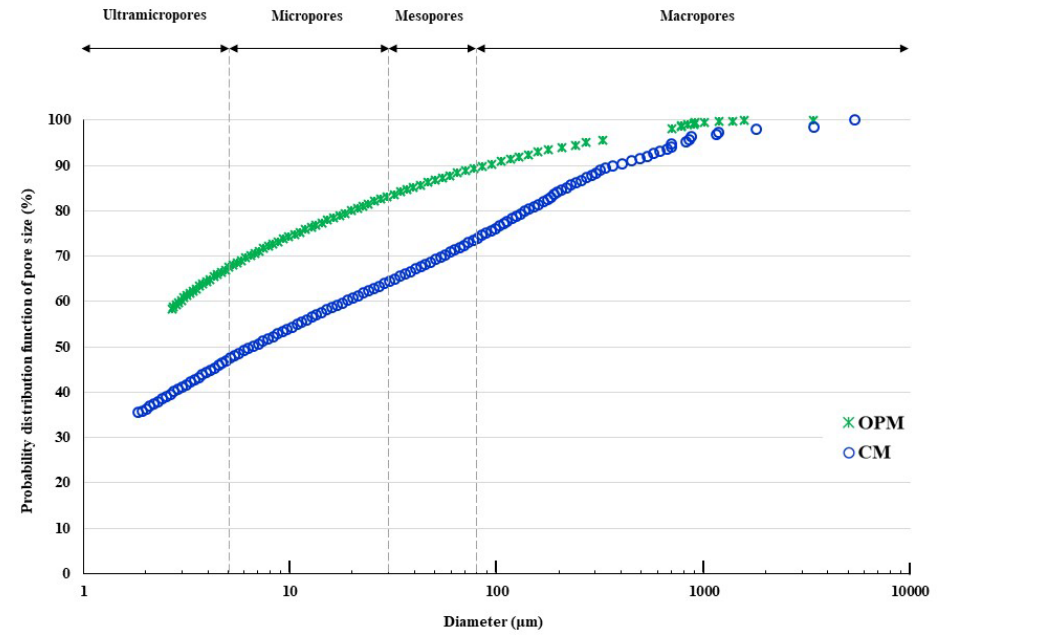
Figure 2. Probability distribution function of pore size (mean of three replicates) of the soil under the two studied treatments (OPM and CM) and pore size classification (Weil and Brady, 2017). Note: x axis in logarithmic scale.